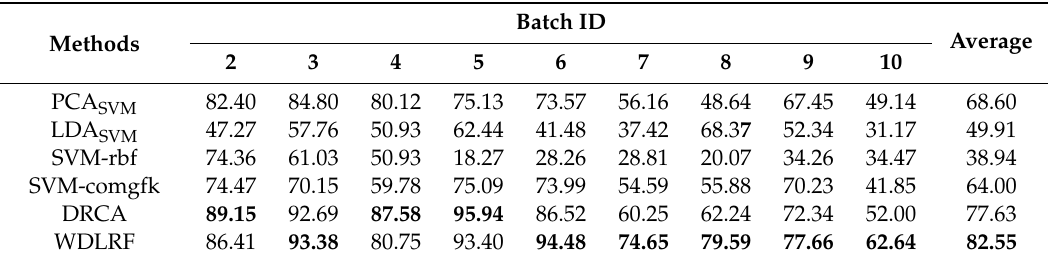
Figure 4. Recognition accuracy bar chart under Experimental Setting 1 and Setting 2. Table 2. Recognition Accuracy (%) under Experimental Setting 1. The bold font represents the highest recognition accuracy of a batch in all compared algorithms.